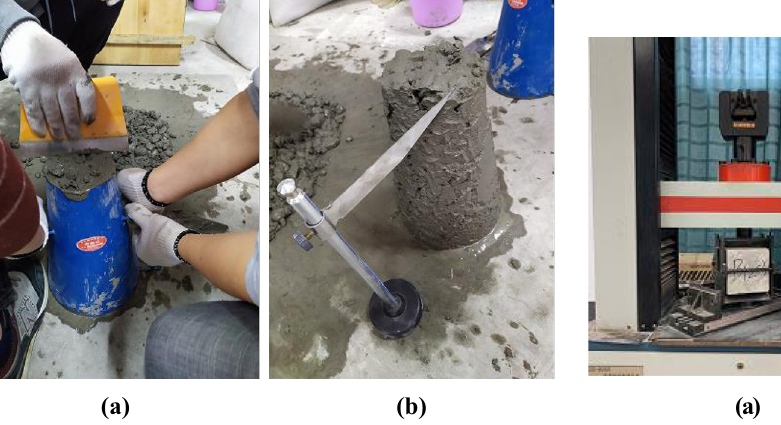
Figure 5: Splitting tensile strength test: ( a ) test device and ( b ) test